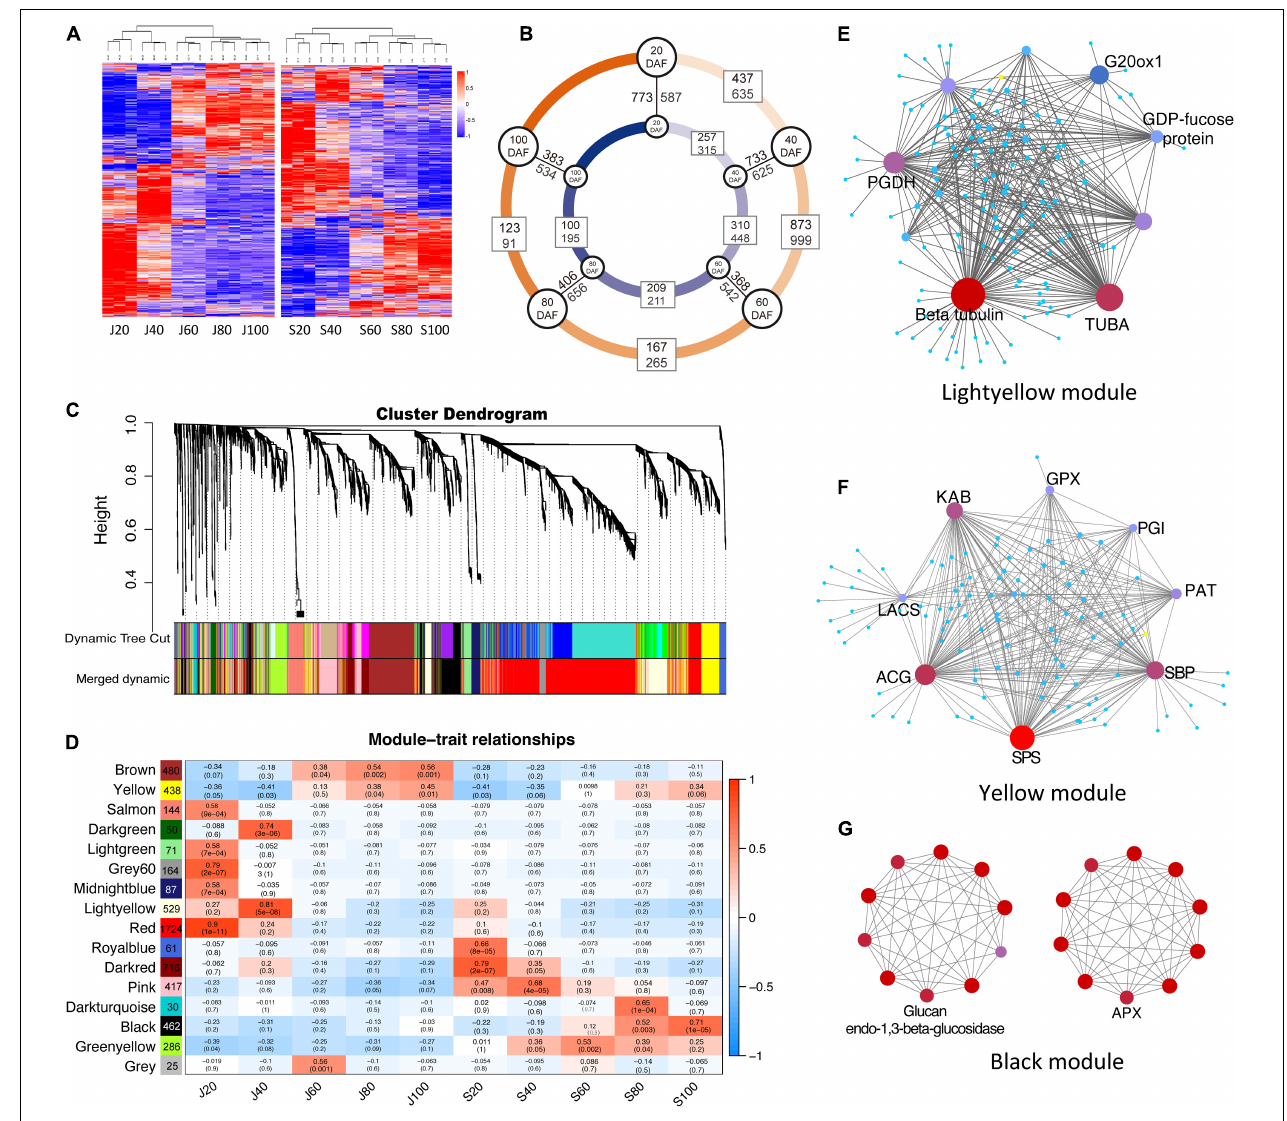
FIGURE 4 | Proteomic profile and protein co-expression network analysis during the fruit development of ‘Junzao’ and ‘Qingjiansuanzao’. (A) Heatmap representation of protein expression profile during fruit development. J20–J100 and S20–S100 represent 20, 40, 60, 80, and 100 DAF of ‘Junzao’ and ‘Qingjiansuanzao,’ respectively. (B) Number of differential expressed proteins (DEPs) detected between neighbor stages and between ‘Junzao’ (indicated by a blue inner circle) and ‘Qingjiansuanzao’ (orange outer circle) at the same stage. (C) Hierarchical cluster tree of co-expression modules identified by weighted gene co-expression network analysis (WGCNA). Each leaf in the tree represents one protein and each tree branch stands for a module. (D) Module–fruit developmental stage associations. The color of each cell at the row–column intersection indicates the correlation coefficient r (up) between the modules (row) and the protein expression profile at a fruit developmental stage (column) and the r-associated significance p -value (down). The WGCNA network of top hub genes in modules Yellow (E) , Lightyellow (F) , and Black (G) . PGDH, D-3-phosphoglycerate dehydrogenase; ACG, glucose-6-phosphate 1-dehydrogenase; SBP, selenium-binding protein 2; SPS, sucrose-phosphate synthase; KAB, voltage-gated potassium channel; PAT, bifunctional aspartate aminotransferase and glutamate; GPX6, phospholipid hydroperoxide glutathione peroxidase 6; LACS2, long chain acyl-CoA synthetase 2; PGIC1, glucose-6-phosphate isomerase; ALDH3H1,